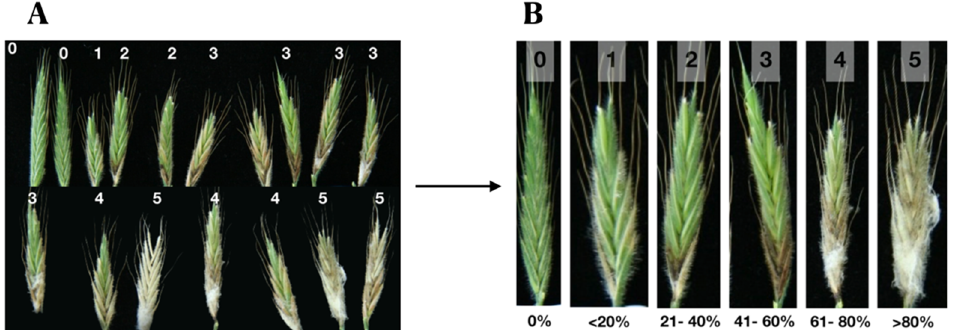
Figure 9. Construction of the severity scale for the infection head assay (IHA). Heads inoculated with Fg -K1-4. ( A ) Two weeks after inoculation, heads were collected, and a grade was assigned accordingly. ( B ) A total of six grades were made (0–5), which represents the % of progression of the disease and is called the Disease severity index (% DSI). variance ( p > 0.05), but there was homogeneity of covariances, as assessed by Box’s test of equality of covariance matrices ( p = 0.002).